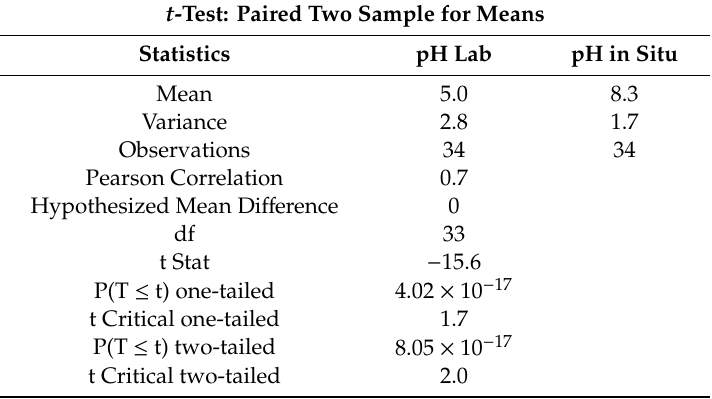
Table A4. The t -test results for comparing pH measured in laboratory (pH lab) and the pH measured in